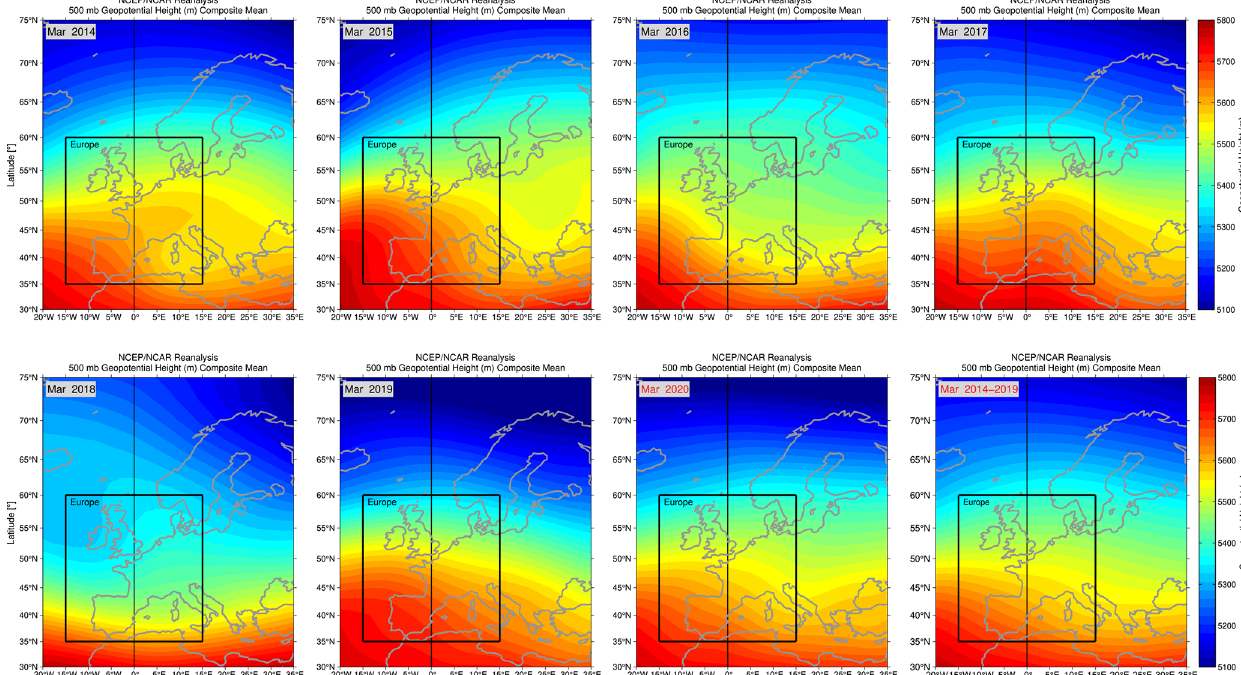
Figure 1. The 500mb geopotential height composite mean in March for the years from 2014 to 2020 (with the years indicated in the plot) and for the average in the previous years 2014–2019 (rightmost bottom panel) over Europe. The black boxes indicate the research area of this study. The plots are reproduced based on NCEP/NCAR Reanalysis provided by Physical Sciences Laboratory, NOAA, Boulder, Colorado, (https://psl.noaa.gov/, last access: 6 May 2021).